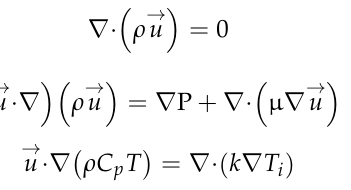
Figure 3. Temperature contours vs. time for each type of heat sink.